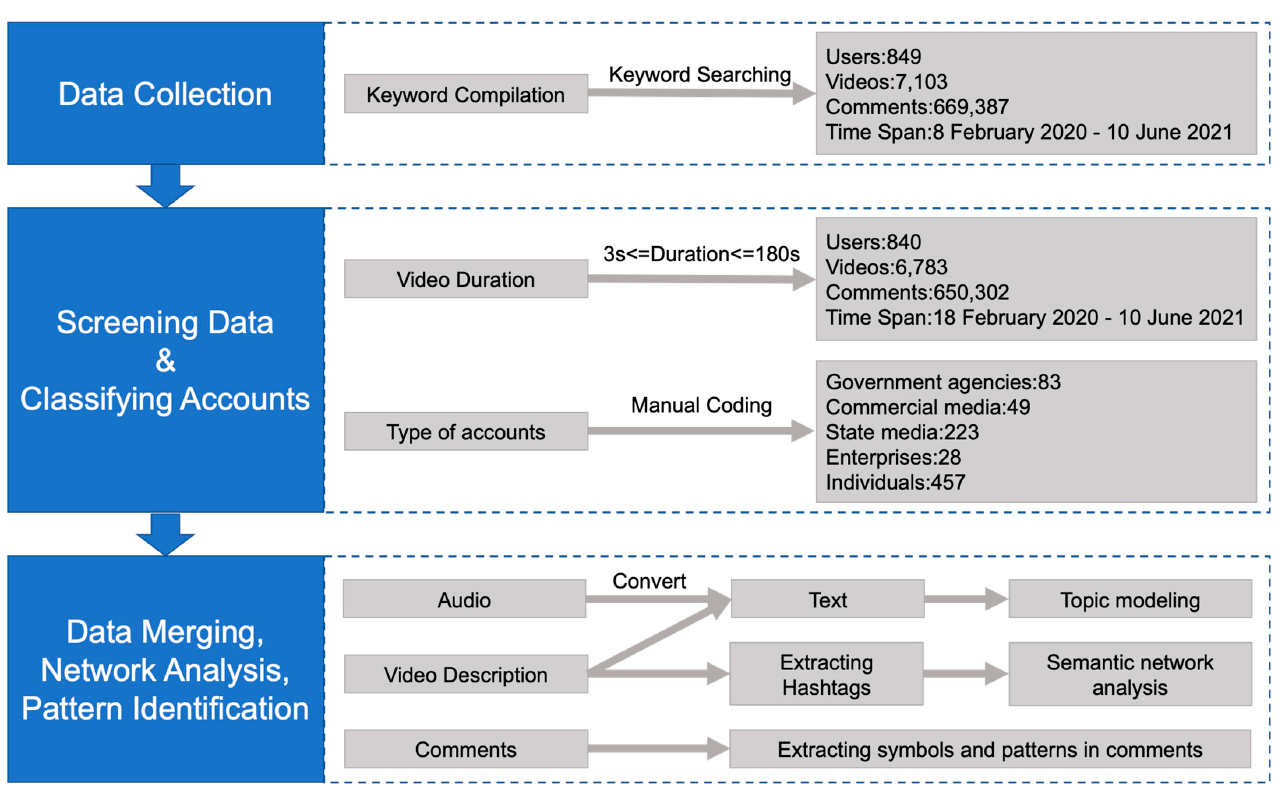
Figure 1. The procedure of data